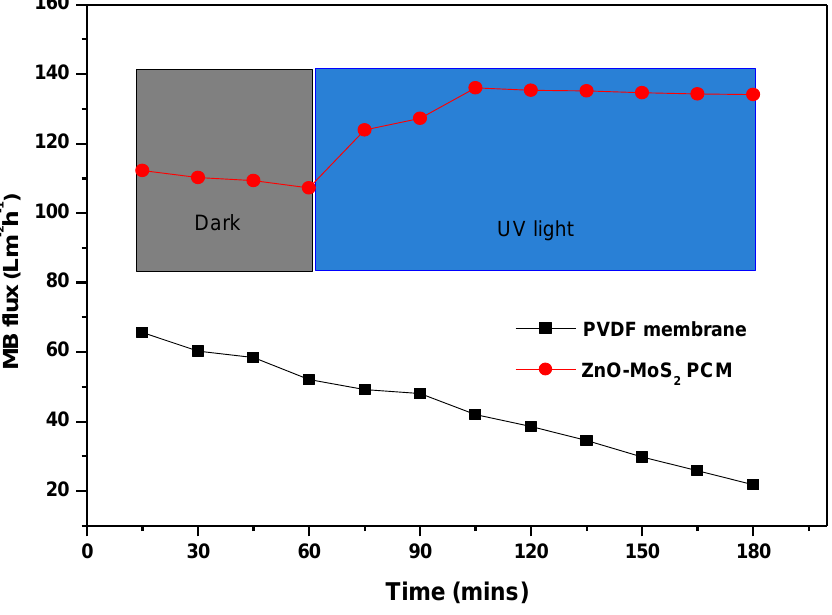
Figure 12. Permeability of PVDF vs. the ZnO-MoS 2 PCM during the MB dye filtration.